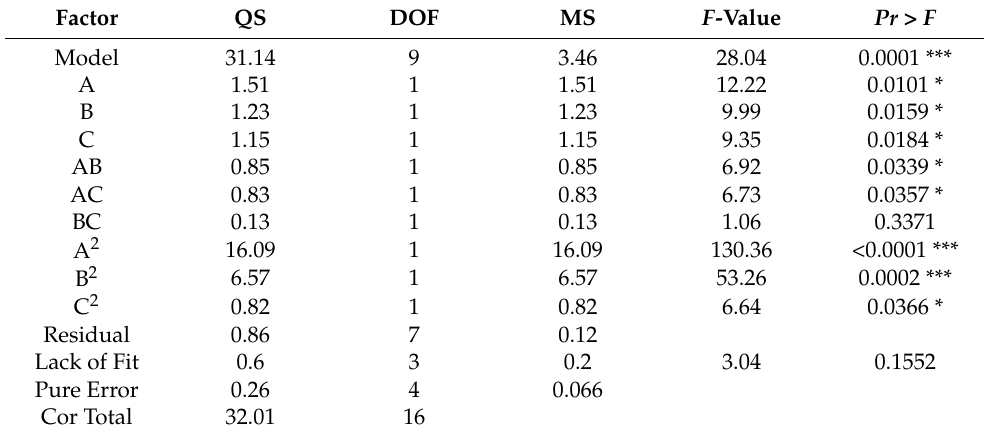
Table 1. Analysis of variance of regression